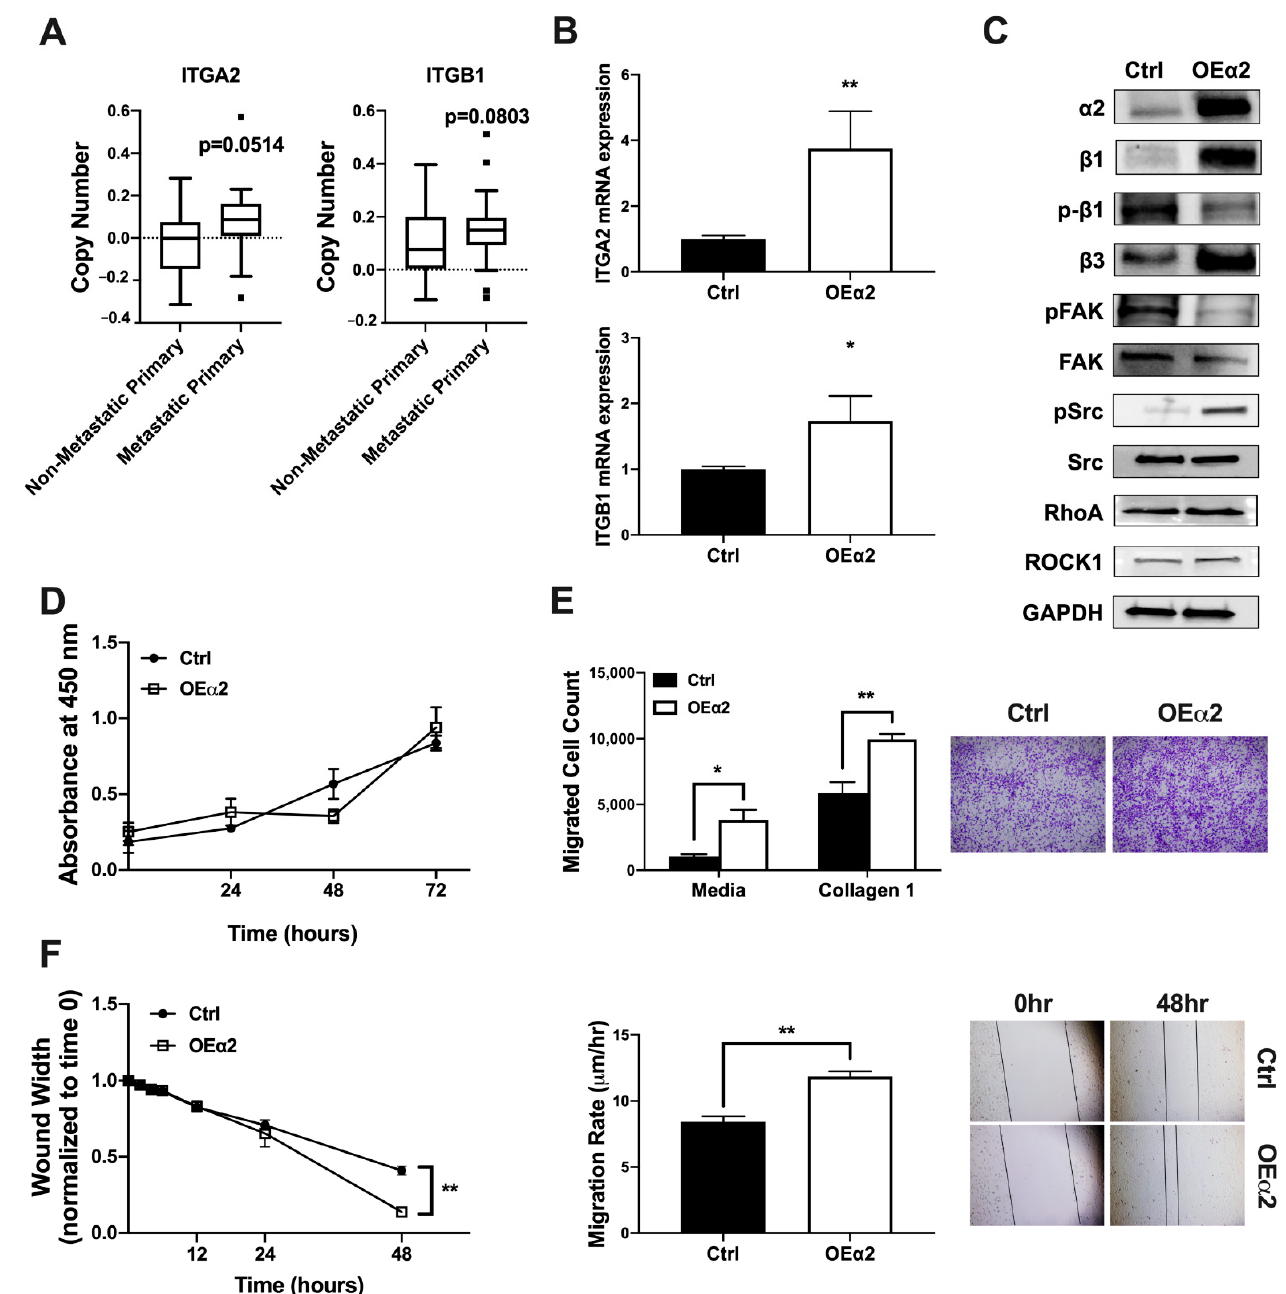
Figure 1. ( A ) Whole exome sequencing of tumor biopsies from patients collected under the Metastatic Breast Cancer